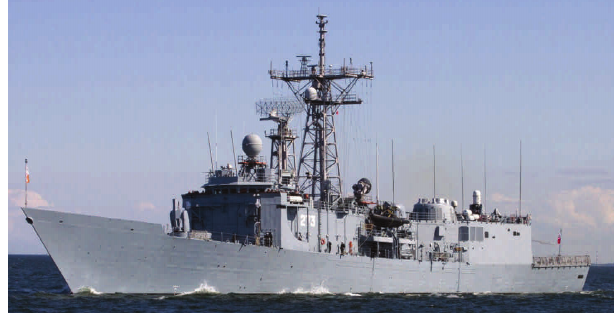
Fig. 3. Oliver Hazard Perry class missile frigate [11]